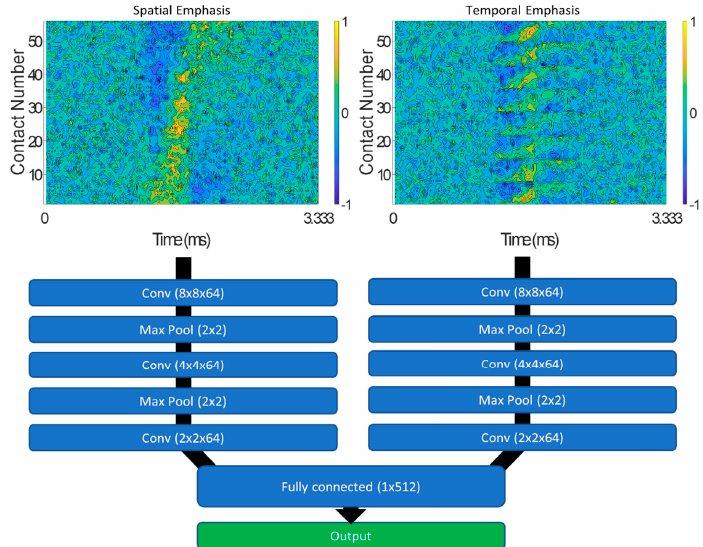
Figure 4. ESCAPE-NET (extraneural spatiotemporal compound action potential extraction network) architecture with spatial and temporal emphasis representations of the multi-contact nerve cuff recordings (signal-to-noise ratio (SNR) = − 5 dB) shown as input to the network [42].